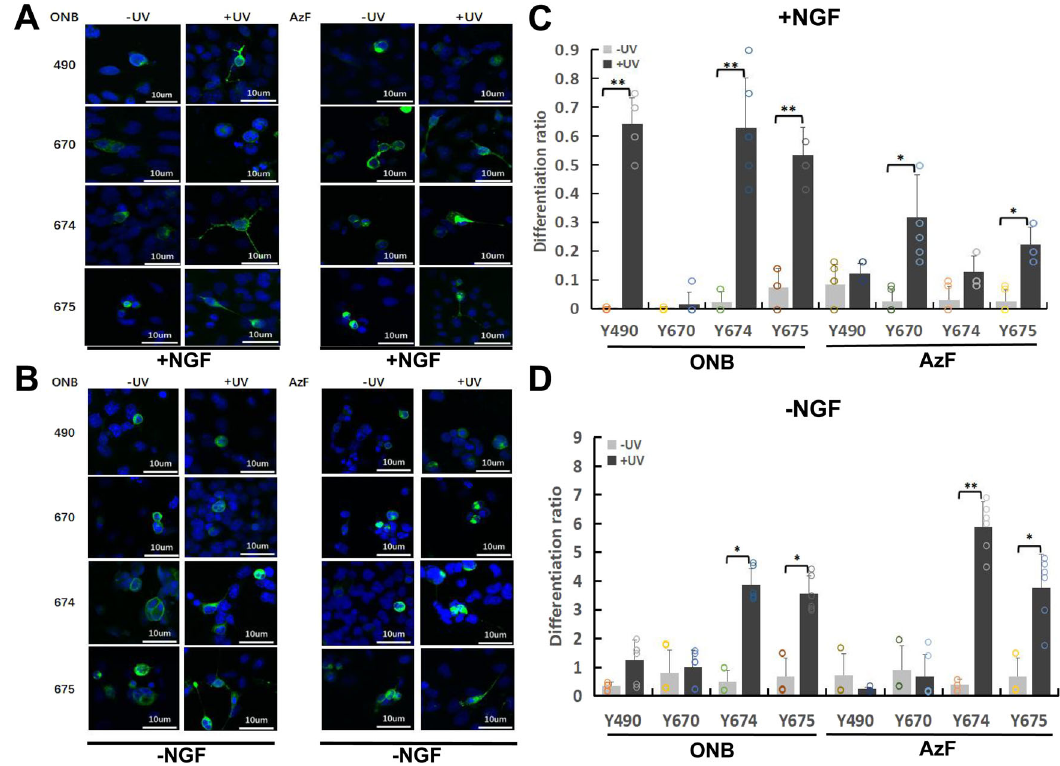
Fig. 6 TrkA-ONB and AzF mutants promote SH-SY5Y cell differentiation in response to UV Stimulation with and without NGF. a Representative fl uorescence images depicting SH-SY5Y cells expressing TrkA-ONB (two columns on the left) or AzF (two columns on the right) mutants incorporated at indicated sites before (-UV) and after ( + UV) treatment, with medium supplied with 100 ng/mL NGF for 30 min and kept in the dark for 24 h prior to imaging. b Representative fl uorescence images depicting SH-SY5Y cells expressing TrkA-ONB (two columns on the left) or AzF (two columns on the right) mutants incorporated at indicated sites before (-UV) and after ( + UV) treatment with medium supplied without NGF. c Differentiation ratios were calculated for various mutants expressed in SH-SY5Y cells in the presence of NGF with or without UV light. d Differentiation ratios calculated for SH-SY5Y cells in the absence of NGF expressing wt-TrkA (WT) or various mutants with or without UV light. Differentiation ratios were calculated as described in the method. Values represent the mean ± SD of six biological replicates ( n = 6) with >200 cells counted per replicate. Scale bars, 10 µ